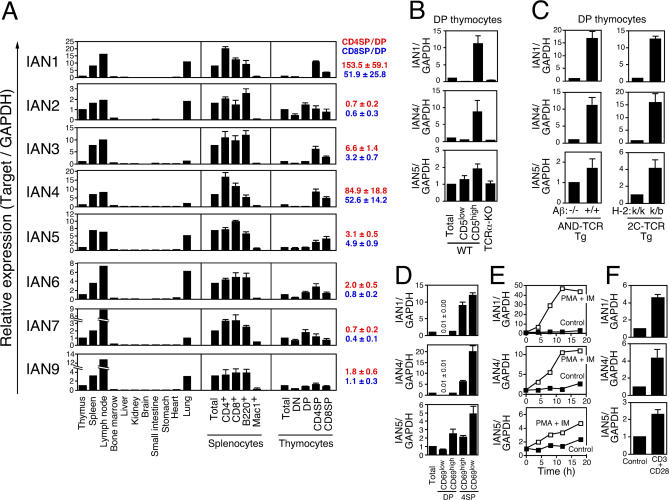
Expression of Mouse IAN Family Genes(A) Quantitative RT-PCR analysis of total RNA from C57BL/6 mouse tissues, purified splenocyte subsets, and purified thymocyte subsets. The mRNA levels of IAN family genes were initially normalized to
GAPDH levels, and were further normalized to the levels expressed in the thymus. Relative expression of all IAN family genes in the thymus tissue is indicated as 1.
(B) Relative mRNA levels of
IAN1, IAN4, and
IAN5 in CD4
+CD8
+, CD4
+CD8
+CD5
low, and CD4
+CD8
+CD5
high thymocytes from C57BL/6 (wild-type) mice and CD4
+CD8
+ thymocytes from TCRα-deficient mice [
42].
(C)
IAN1, IAN4, and
IAN5 mRNA levels in CD4
+CD8
+ thymocytes from positive selector (AND-TCR Aβ
+/+ and 2C-TCR
k/b [
43]) TCR-transgenic mice and null selector (AND-TCR Aβ
−/− [
44] and 2C-TCR
k/k) TCR-transgenic mice.
(D) Relative mRNA levels of
IAN1, IAN4, and
IAN5 in total, CD4
+CD8
+CD69
low, CD4
+CD8
+CD69
high, CD4
+CD8
−CD69
high and CD4
+CD8
−CD69
low thymocytes from C57BL/6 mice.
(E) Thymocytes from TCRα-deficient mice were cultured with or without phorbol 12-myristate 13-acetate (0.2 ng/ml) and ionomycin (0.2 μg/ml) for the indicated periods.(F) Thymocytes from Aβ
−/− β2m
−/− mice [
45] were cultured with or without plate-bound anti-CD3 (clone 2C11) and anti-CD28 (clone 37.51) antibodies for 24 h.
Bar graphs show means ± standard errors.